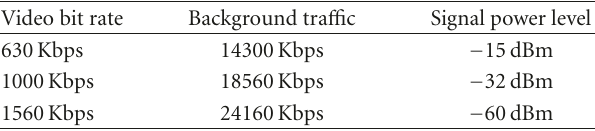
Table 5: Network parameters for model validation.